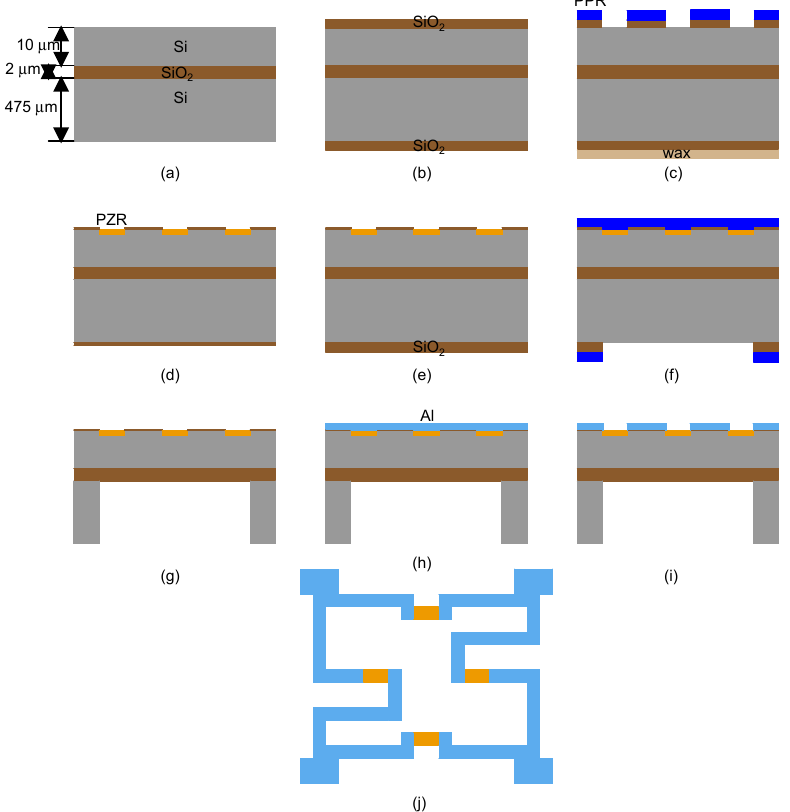
Figure 3. The cross-sectional view of the wafer after some of the major steps: ( a ) starting SOI wafer; ( b ) growth of SiO layer on Si; ( c ) lithography and oxide etching to make 2 windows for piezoresistors; ( d ) boron diffusion; ( e ) SiO deposition using plasma enhanced 2 chemical vapor deposition (PECVD); ( f ) lithography and SiO etching to make a window 2 for back side Si etching; ( g ) bulk Si etching using deep reactive ion etching (DRIE); ( h ) aluminum deposition; ( i ) aluminum etching; and ( j ) top view of the metal